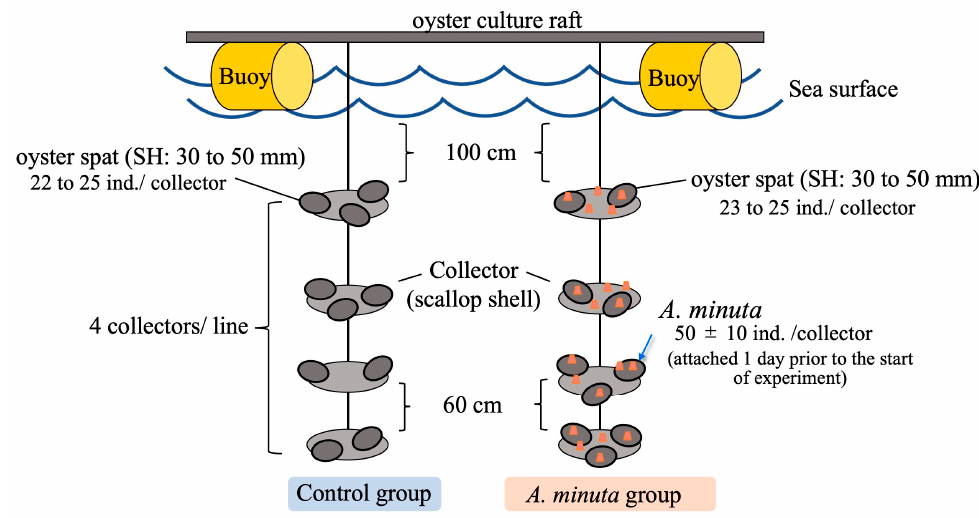
Figure 2. Oyster culture raft containing the spat collectors with either the control group or the A. minuta group.